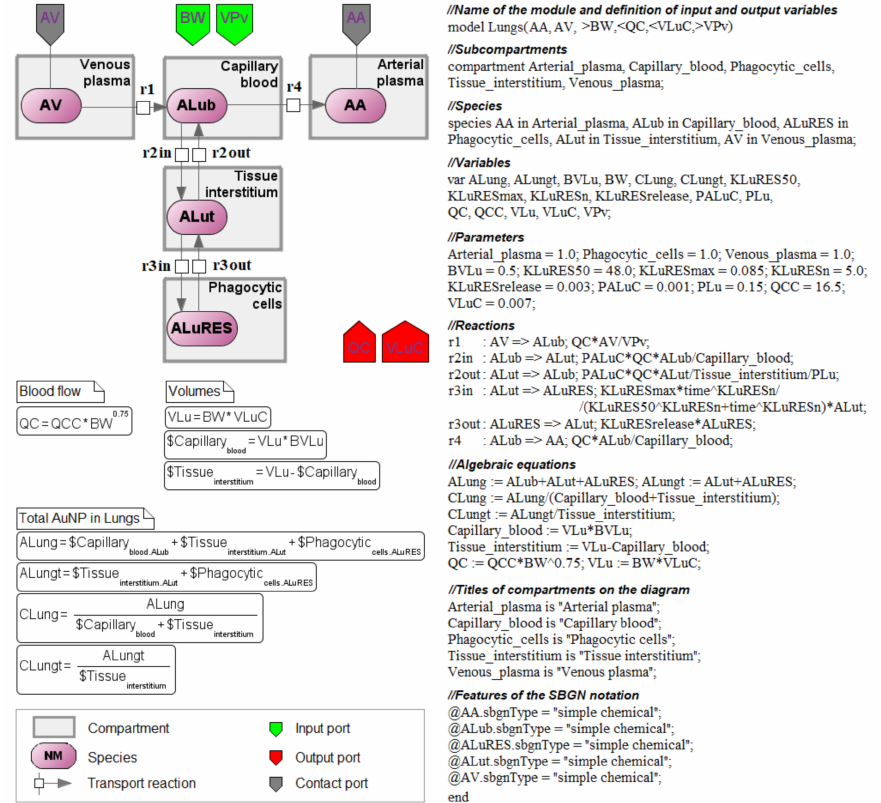
Figure 8. The lung compartment in BioUML using Systems Biology Markup Language (SBML) and SBGN standards and Antimony code. Note that the “sbgnType” tag is not included in the Antimony syntax, as well as specifying the different types of ports (>BW, <QC). We added these extensions to the Antimony implementation to support SBGN objects and allow for modular